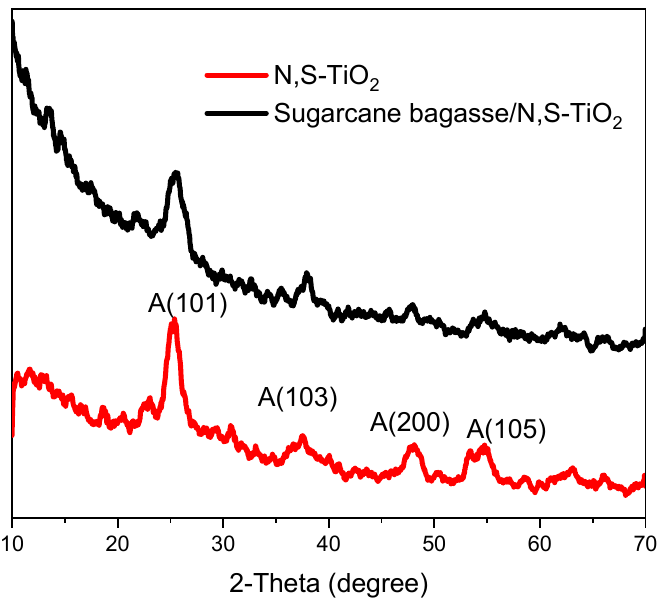
Figure 1. XRD spectrum of N,S-TiO 2 and sugarcane bagasse/N,S-TiO 2 composite.